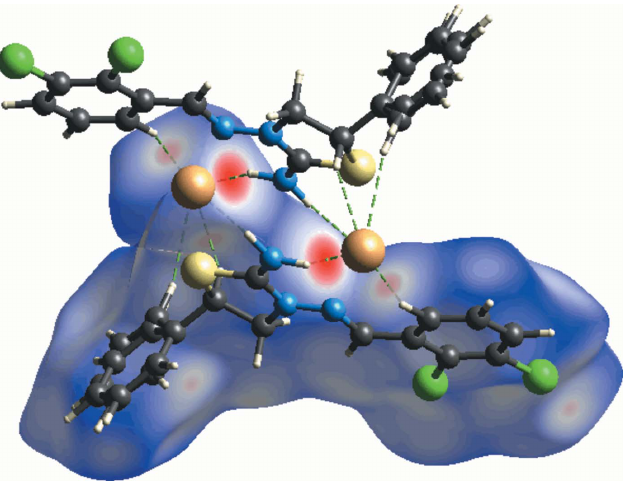
Figure 6 The two-dimensional fingerprint plots of the title salt, showing ( a ) all interactions, and delineated into ( b ) H (cid:2)(cid:2)(cid:2) H, ( c ) Cl (cid:2)(cid:2)(cid:2) H/H (cid:2)(cid:2)(cid:2) Cl, ( d ) C (cid:2)(cid:2)(cid:2) H/H (cid:2)(cid:2)(cid:2) C, ( e ) Br (cid:2)(cid:2)(cid:2) H/H (cid:2)(cid:2)(cid:2) Br and ( f ) S (cid:2)(cid:2)(cid:2) H/H (cid:2)(cid:2)(cid:2) S interactions.